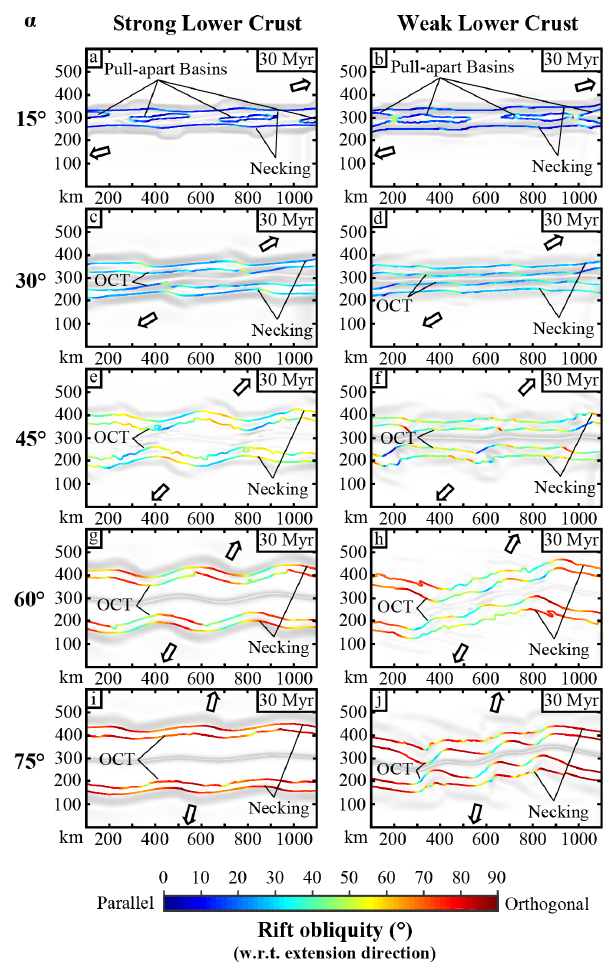
Figure 11. Map view of each model representing the angle of the ocean–continent transition (OCT) and the necking zone with respect to the extension direction. The background represents the topogra- phy with hill shading. Models with α = 15 ◦ and 45 ◦ with a strong lower crust and the model α = 60 ◦ with a weak lower crust are high- resolution models (models 1, 2, and